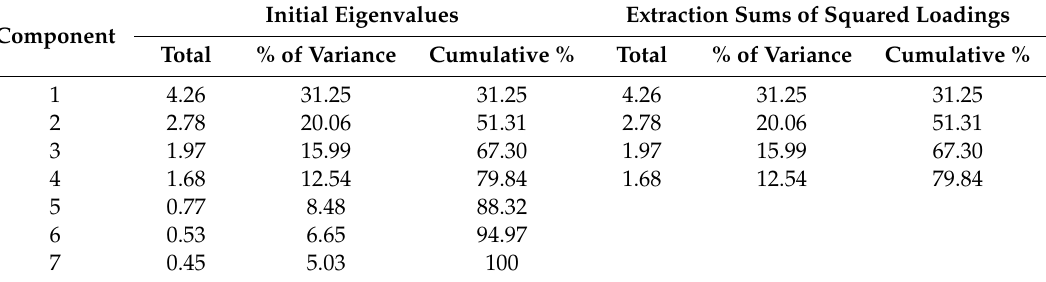
Table 1. Total variance explained by the components.